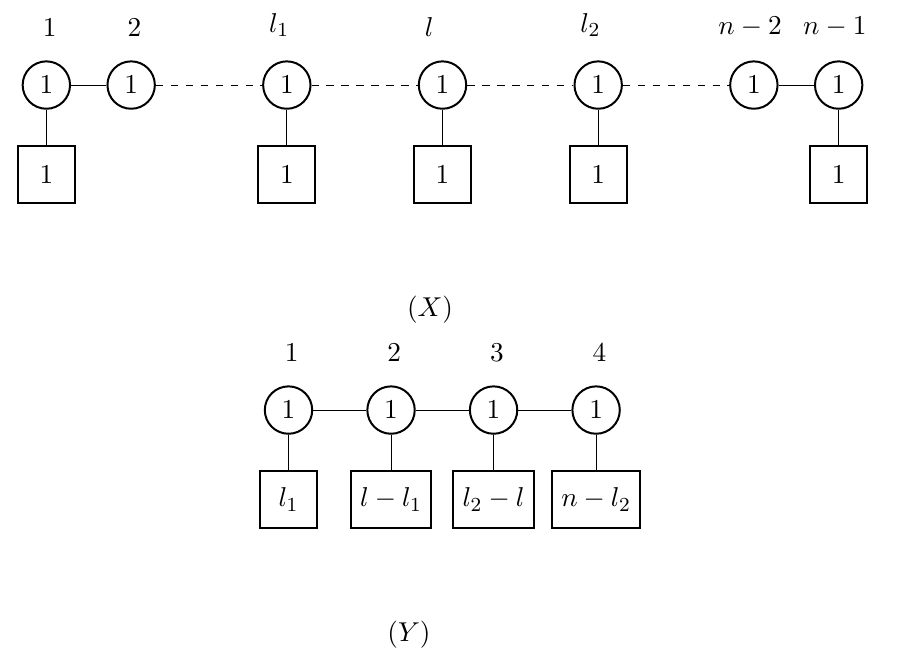
Figure 21 . Pair of linear quivers with U(1) gauge groups which generate the 3d mirrors in figure 20.